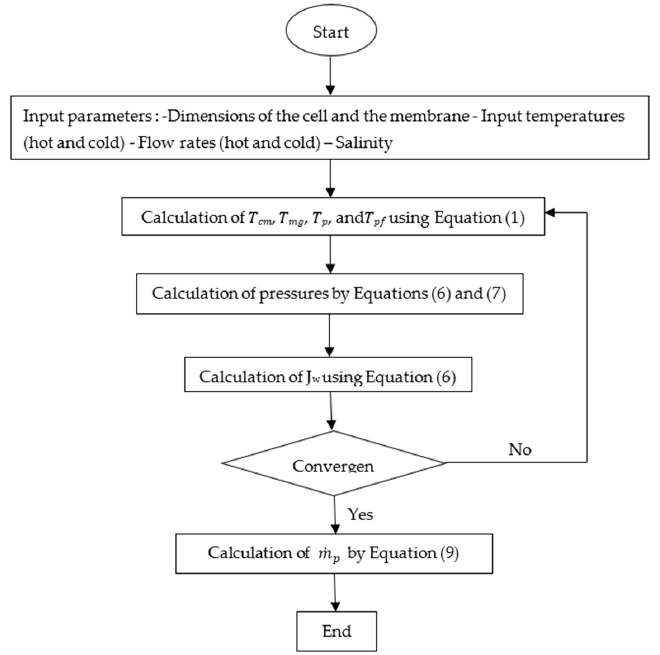
Figure 2. Flowchart of mass fl ow calculation.